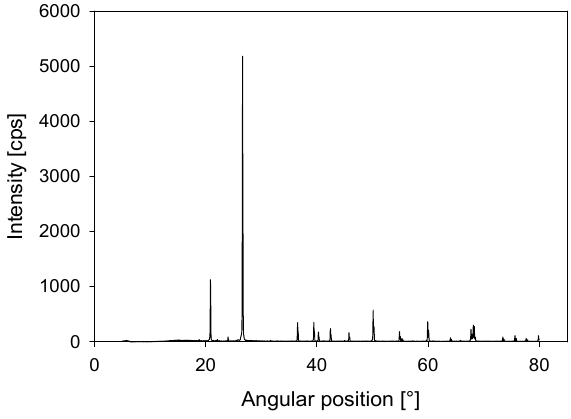
Figure 3. X-ray diffraction (XRD) for quartz powder.